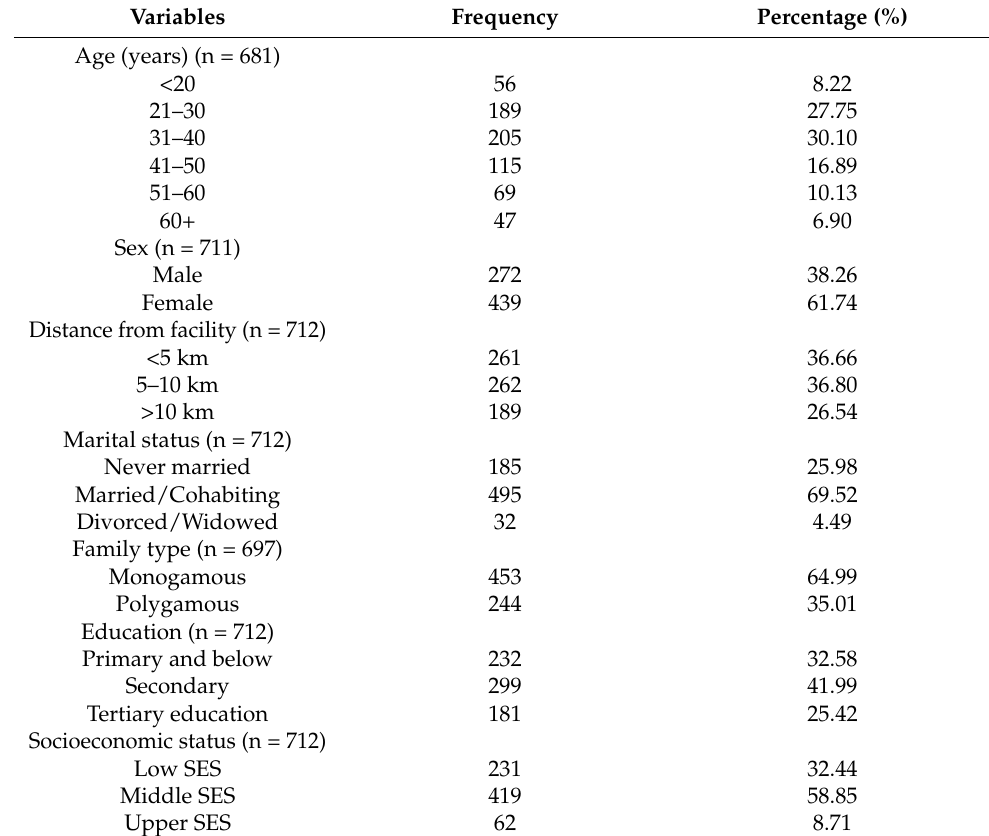
Table 2. Socio-demographic characteristics of the study participants (n = 712).